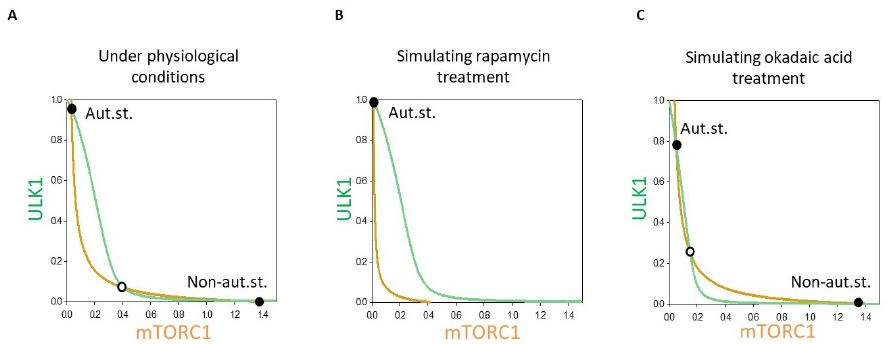
Figure 4. The dynamical feature of PP2A-mTORC1-ULK1 regulatory triangle controlled stress response mechanism. Phase plane diagram of PP2A-mTORC1-ULK1 regulatory triangle ( A ) under physiological conditions, upon ( B ) rapamycin (mTORT = 0.1) or ( C ) OA treatment (PP2AT = 0.3). The balance curves of ULK1 (green curve) and mTORC1 (orange curve) are plotted. Stable and unstable steady states are visualized with black and white dots, respectively. “Non-aut. state” refers to non-autophagy state (with active mTORC1 and inactive ULK1), while “Aut.st.” refers to “autophagy state” (with active ULK1 and inactive